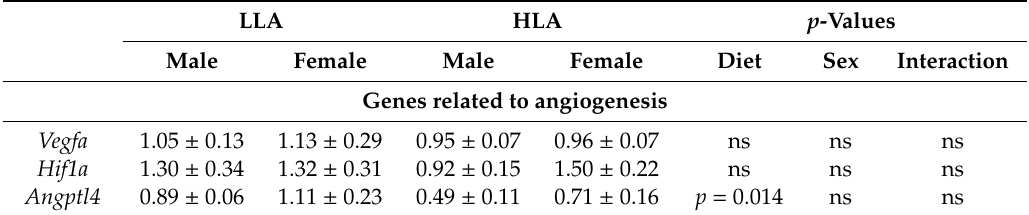
Table 3. E ff ect of a maternal diet high in linoleic acid on relative mRNA expression of genes related to angiogenesis, glucose transport and amino acid transport in the labyrinth zone of the rat